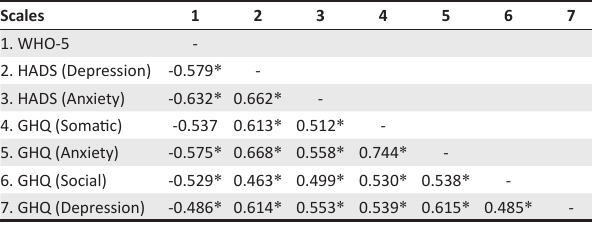
TABLE 4: Correlation between WHO-5, HADS and GHQ scales. Scales